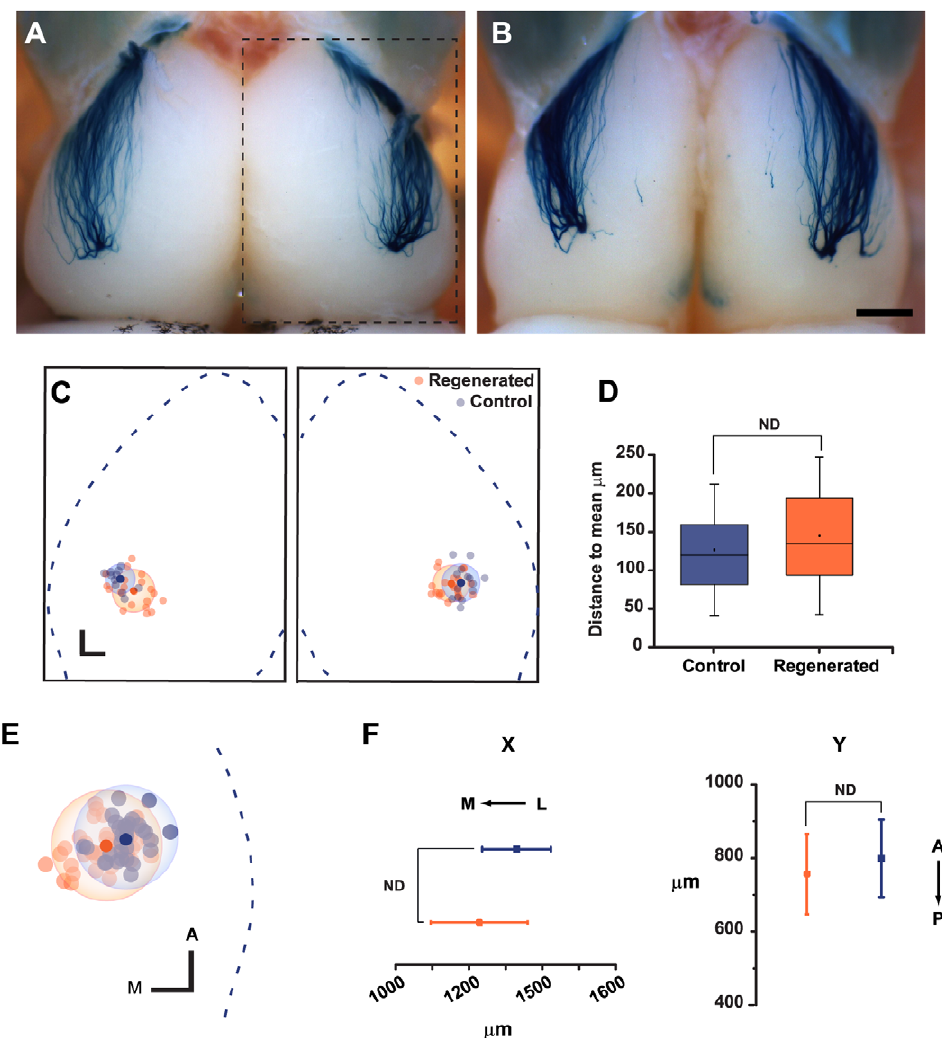
Figure 3. Position of M72 lateral glomerulus is recovered after regeneration. A , Image of the dorsal aspect of a M72-IRES-tauLacZ control mouse showing the lateral glomeruli on the surface of OB. B , Representative image of M72 lateral glomeruli 45 days after methimazole administration. Notice the striking similar pattern of innervation compared to control animals. C , Summary of glomerular distribution after regeneration. The normalized dorsal aspect of olfactory bulbs is represented (dashed line in A shows the OB contour taken in every image to perform the normalization), the centroid of all glomeruli in control animals (blue dots) and 45 days post lesion (orange dots). The mean position (filled dots) and 2 standard distances (transparent spheres around the means) are shown. D , Box plot of the values of Euclidean distances showing no significant differences between control and regenerated mice. E , All glomeruli projected on the right plane at a higher magnification. F , The analysis of the mean position carried on the normalized X- and Y-axes shows no significant differences in glomerular location following regeneration. Mean 6 SD are represented. Scale bars 500 m m (C) and 200 m m (D, F). Latero-medial (L–M), Antero-posterior (A–P), No difference (ND). doi:10.1371/journal.pone.0046338.g003 discriminate the odorants even when tested 45 days after finalizing including the cognate ligands for M72 and I7 receptors the training period (Group 1: 0.7 6 0.04 vs. 0.12 6 0.03, efficiency (acetophenone and heptaldehyde, respectively) [24,47]. Twenty- score in + arm vs. 2 arm; P , 0.05. Group 2: 0.7 6 0.03 vs. four mice were randomly separated into two groups and each 0.8 6 0.01; P , 0.05). Animals from the methimazole-treated group was tested with different pairs of odorants, acetophenone vs (EXP) group were unable to discriminate the different odorants citral (Group 1) or heptaldehyde vs 2-heptanone (Group 2). The 10 days after injection (Group 1: 0.45 6 0.1 vs. 0.43 6 0.2, efficiency task consisted in associating the presence of given odorant in the score in + arm vs. 2 arm; P . 0.05. Group 2: 0.57 6 0.09 vs. environment with receiving water as a reward (details in Material 0.37 6 0.09; P . 0.05). This observation correlates well with the and Methods). Figure 6A illustrates a diagram of the maze and the absence of olfactory sensory neurons in the OE at 10 days after experimental design. Figures 6B and 6C show the performance of methimazole injection (Fig. 2). Remarkably, the EXP Group Group 1 and Group 2 in both (blue dots represent data from the recovered the ability to discriminate the odorants 45 days after rewarded arm of the maze (i.e. the zone with the water reward and lesion (Group 1: 0.7 6 0.06 vs. 0.2 6 0.04, efficiency score in + arm the specific odorant; + arm, blue dots) and the not-rewarded arm vs. 2 arm; P , 0.05. Group 2: 0.60 6 0.08 vs. 0.2 6 0.04; P , 0.05). ( 2 arm, red dots). Control groups retained the ability to